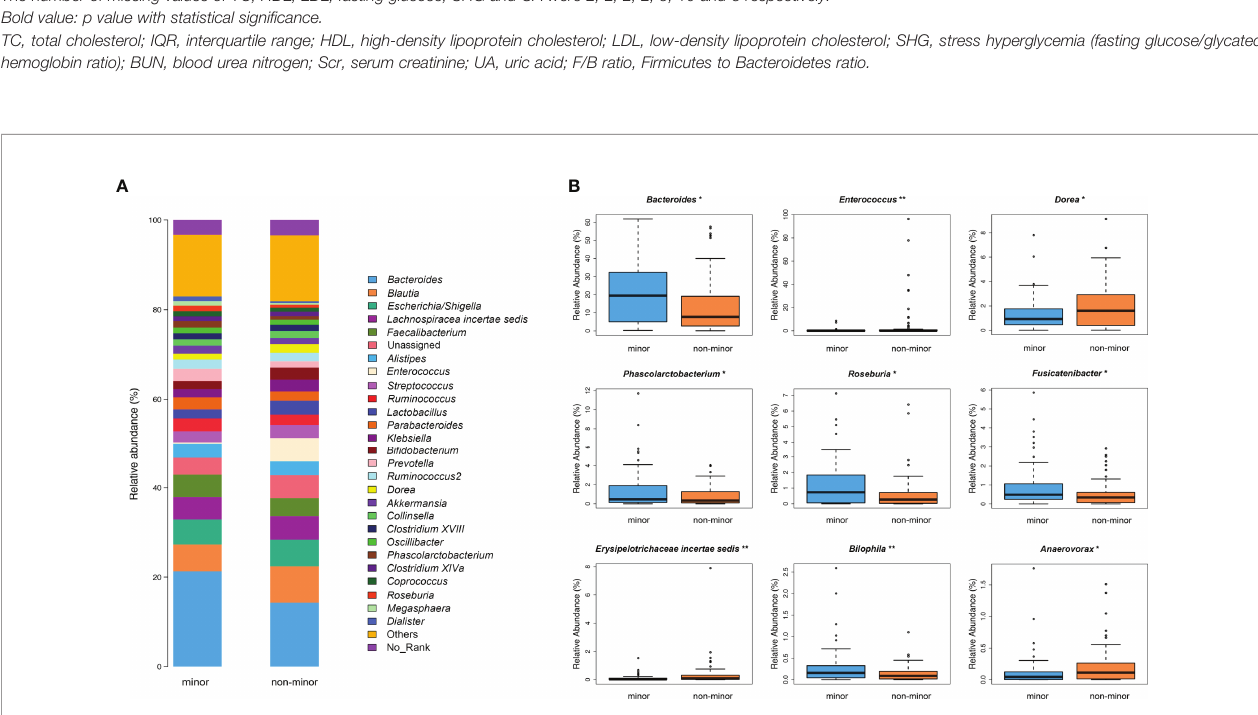
TABLE 3 | Relative abundances of nine potential phenotypes predicted by BugBase in two groups.